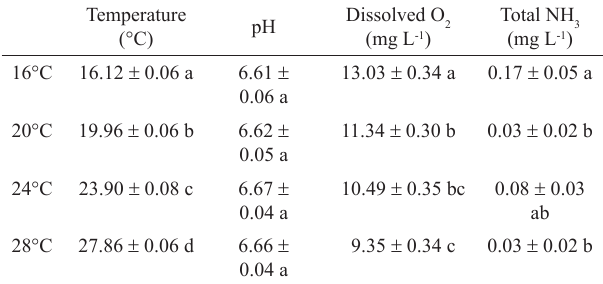
Table 1. Water quality parameters (mean ± standard error) throughout the growth trial of Austrolebias wolterstorffi reared under different temperatures. Letters denote statistical significance across parameters (ANOVA, Tukey, p < 0.05).